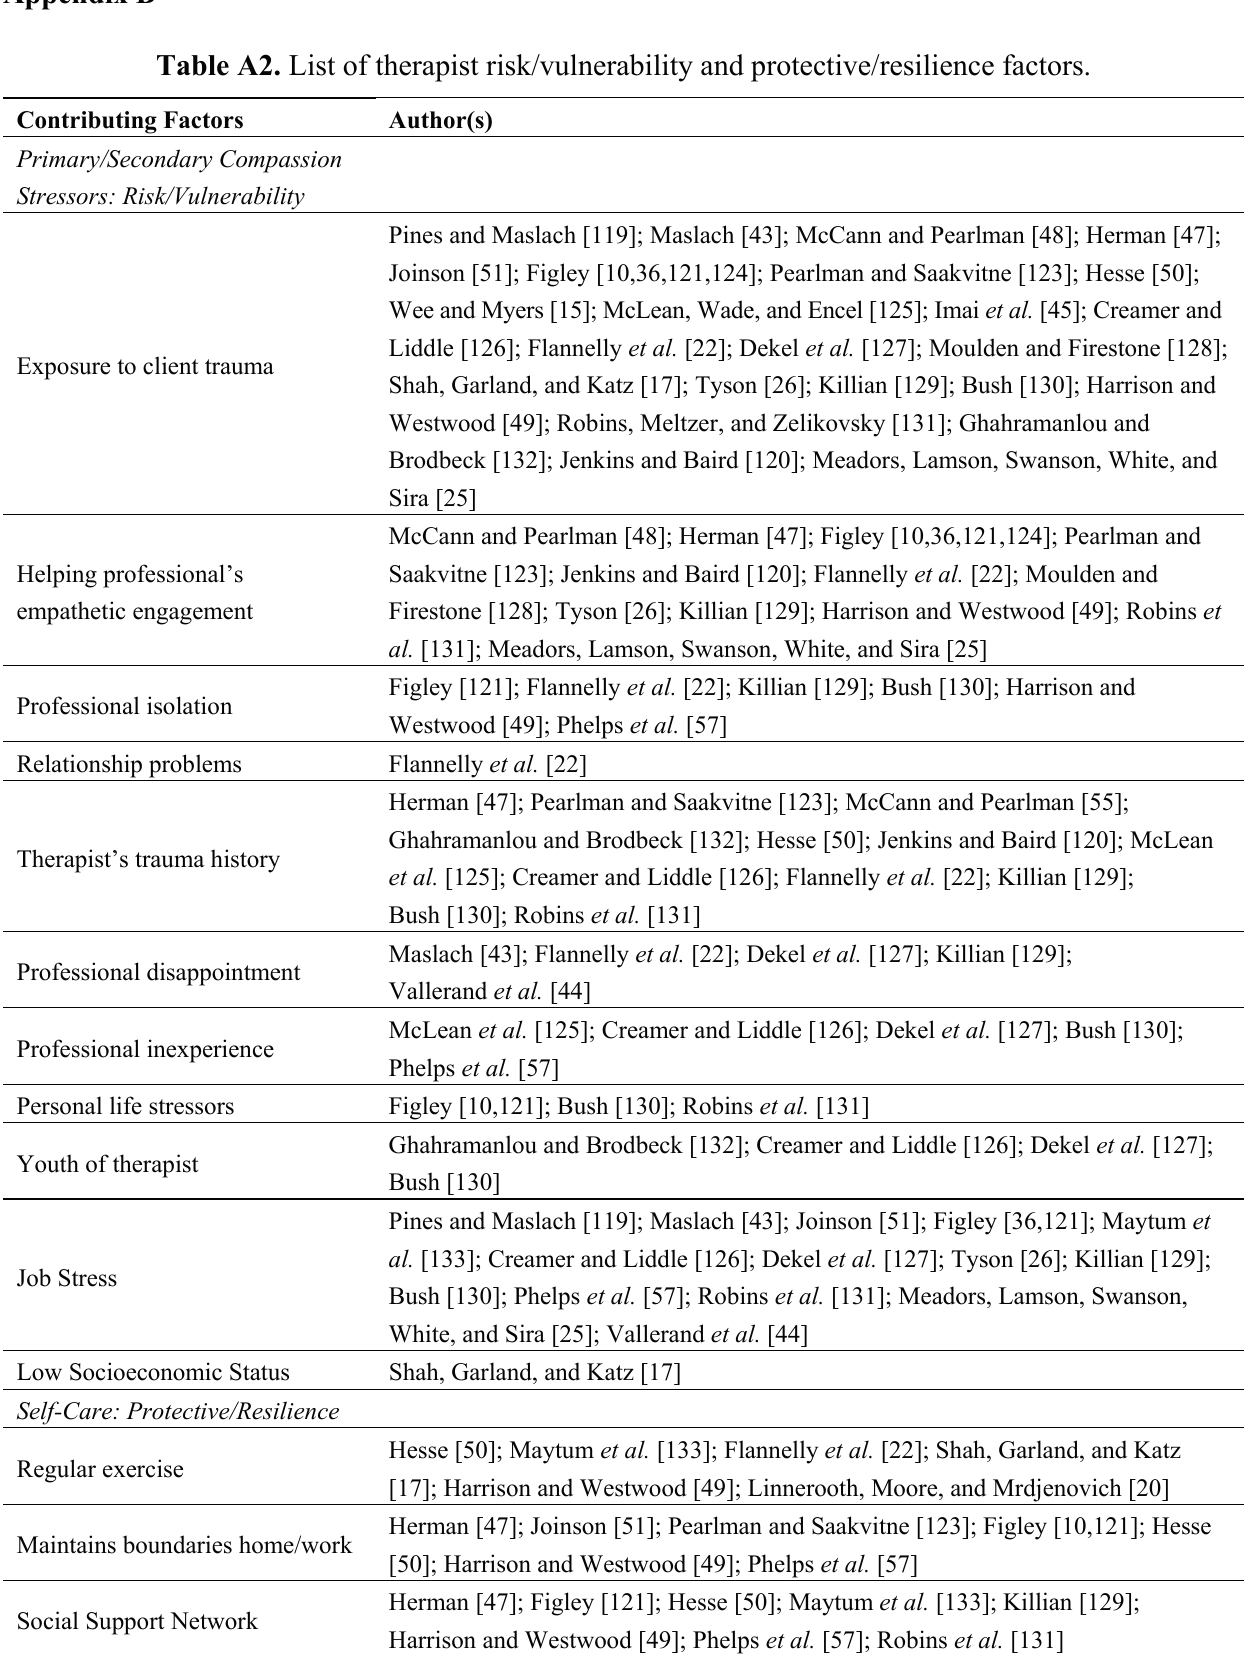
Table A2. List of therapist risk/vulnerability and protective/resilience